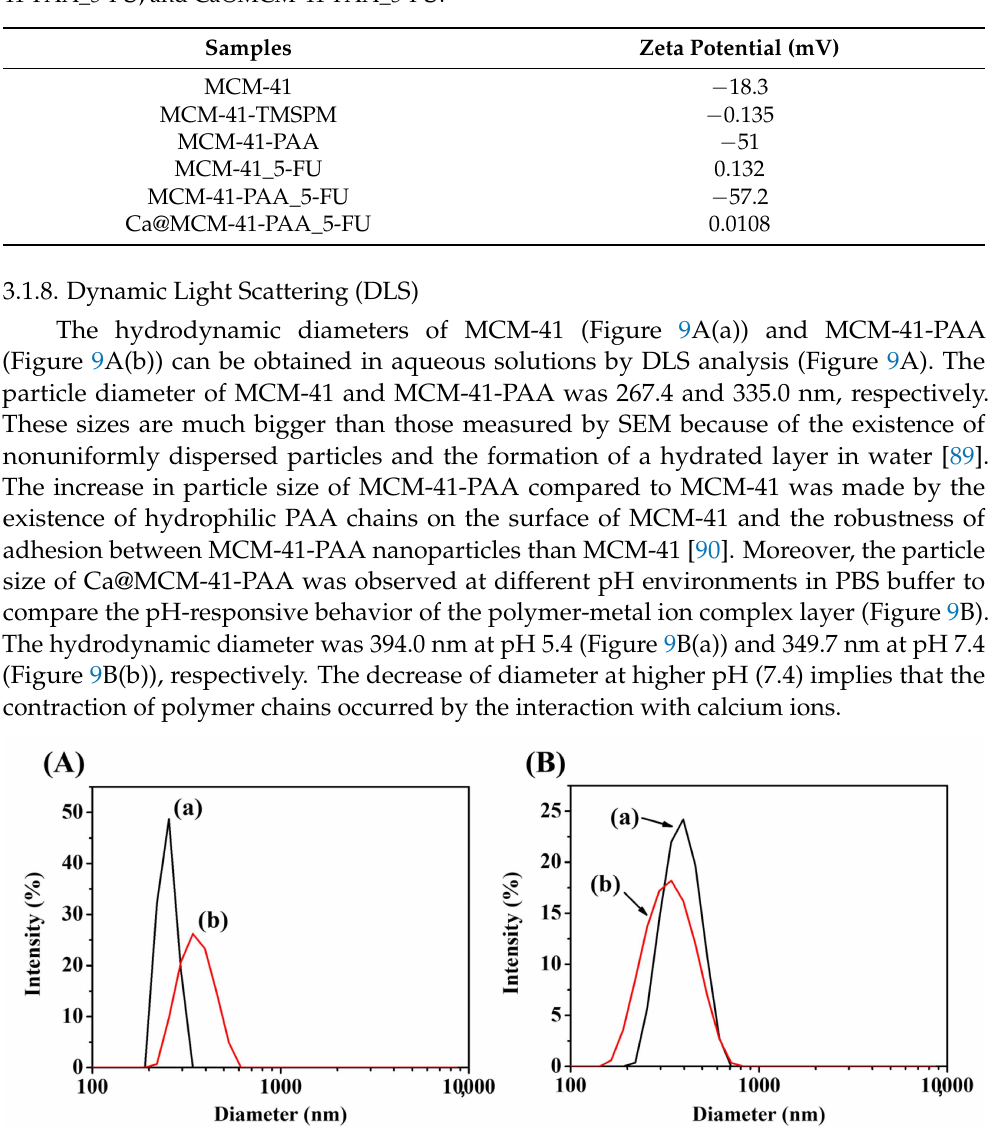
Table 2. Zeta potential values of MCM-41, MCM-41-TMSPM, MCM-41-PAA, MCM-41_5-FU, MCM-